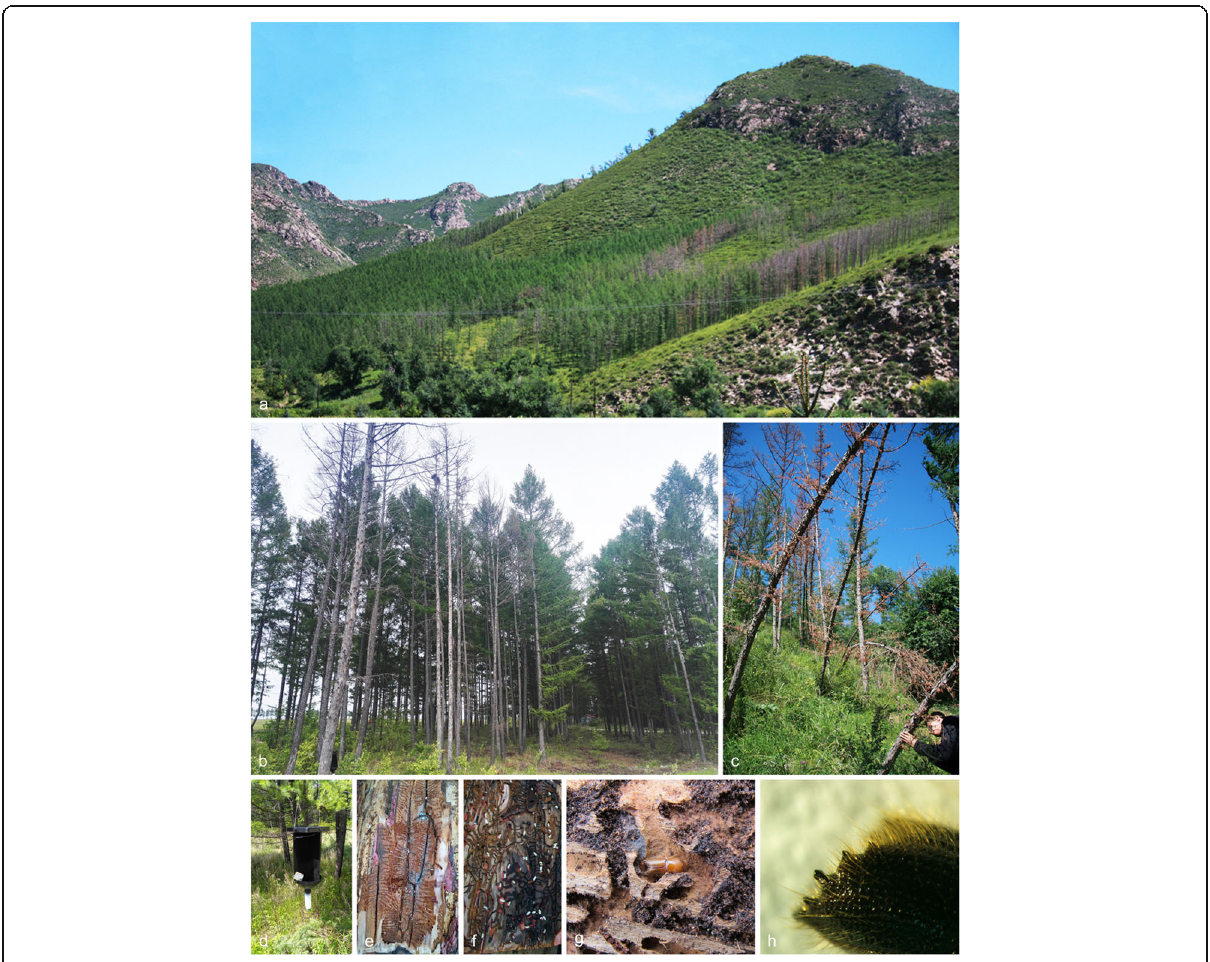
Fig. 1 a – c . Disease symptoms on larch infested by Ips subelongatus and ophiostomatoid fungi in northeastern China; d. Cross barrier type traps used in fields for monitoring the occurrence and population of I. subelongatus ; e – g. Larvae, pupae, and adult of I. subelongatus in galleries on larch; h . Spines of I.